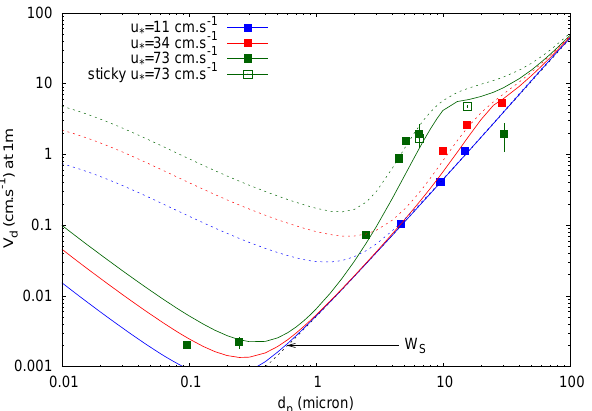
Fig. 4. Deposition on grass, as measured by Chamberlain (1967); Clough (1975); Garland (1983); Gallagher et al. (1988); Nemitz et al. (2002) for friction velocity between 25 and 55cms − 1 . A fric- tion velocity of 40cms − 1 is used to run the model of Zhang et al. (2001, in brown), the 1-D-model on leaf and needle obstacles (red plain and dash) and the present model on leaf and needle obstacles (blue plain and dash). All deposition velocities are re-calculated at z R = 3 . 8m. The particle density is taken as ρ p = 1500kgm − 3 . One should notice a large dispersion within the mea- surements, that is not solely related to experimental uncer- tainty. Differences in canopy morphology (LAI,